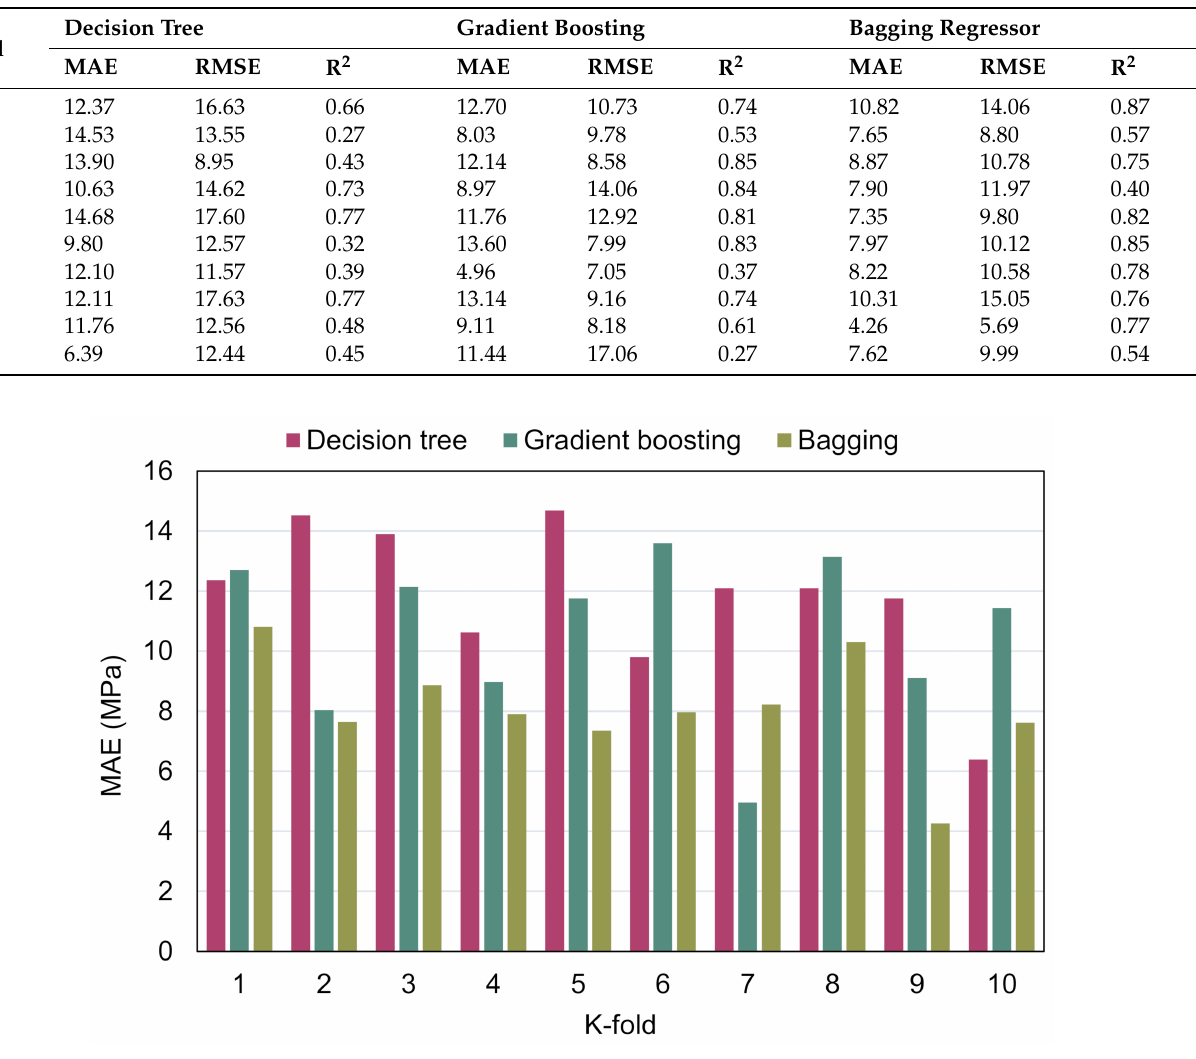
Table 3. Results obtained from the k-fold assessment.